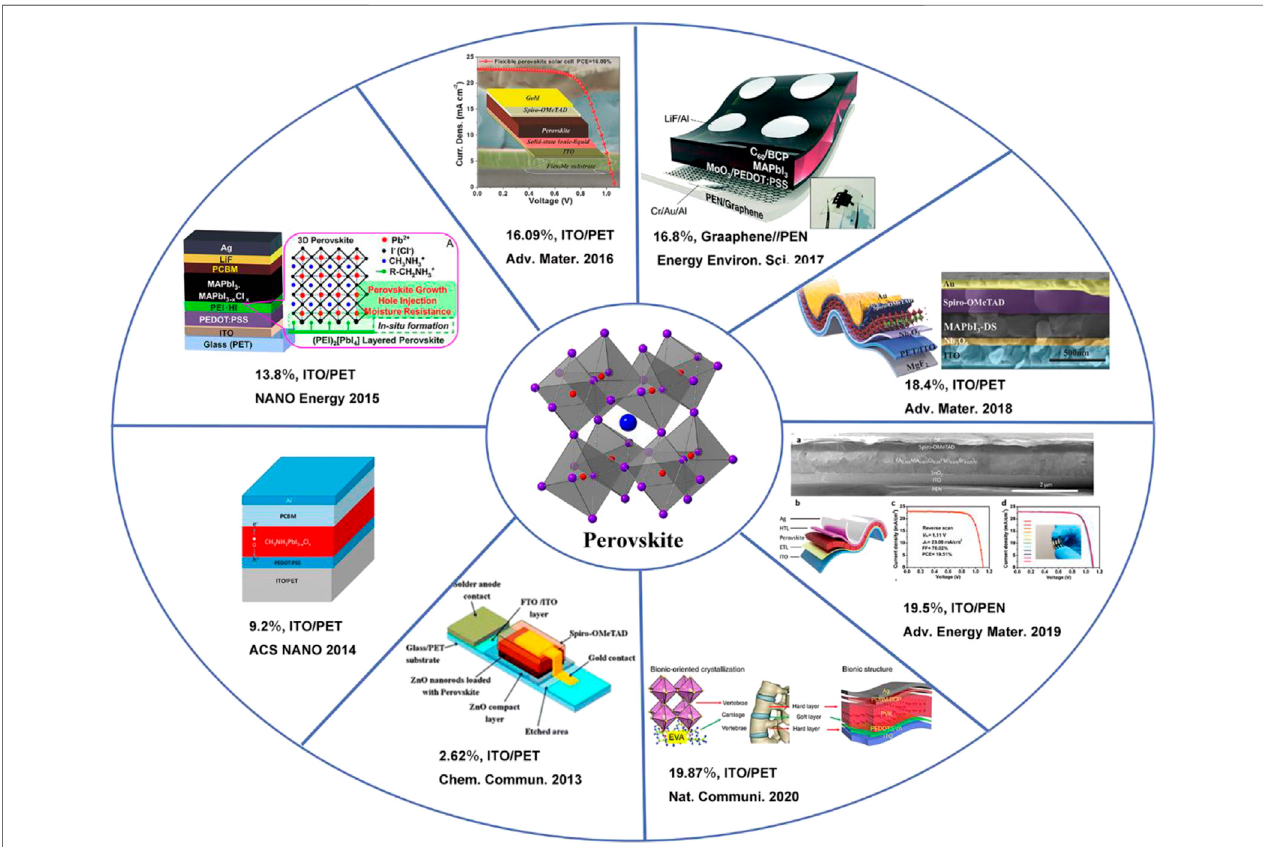
FIGURE 1 | Illustration of the development for FPSCs from 2013 to 2020. This image gives the ef fi ciency and electrode for fl exible perovskite devices.